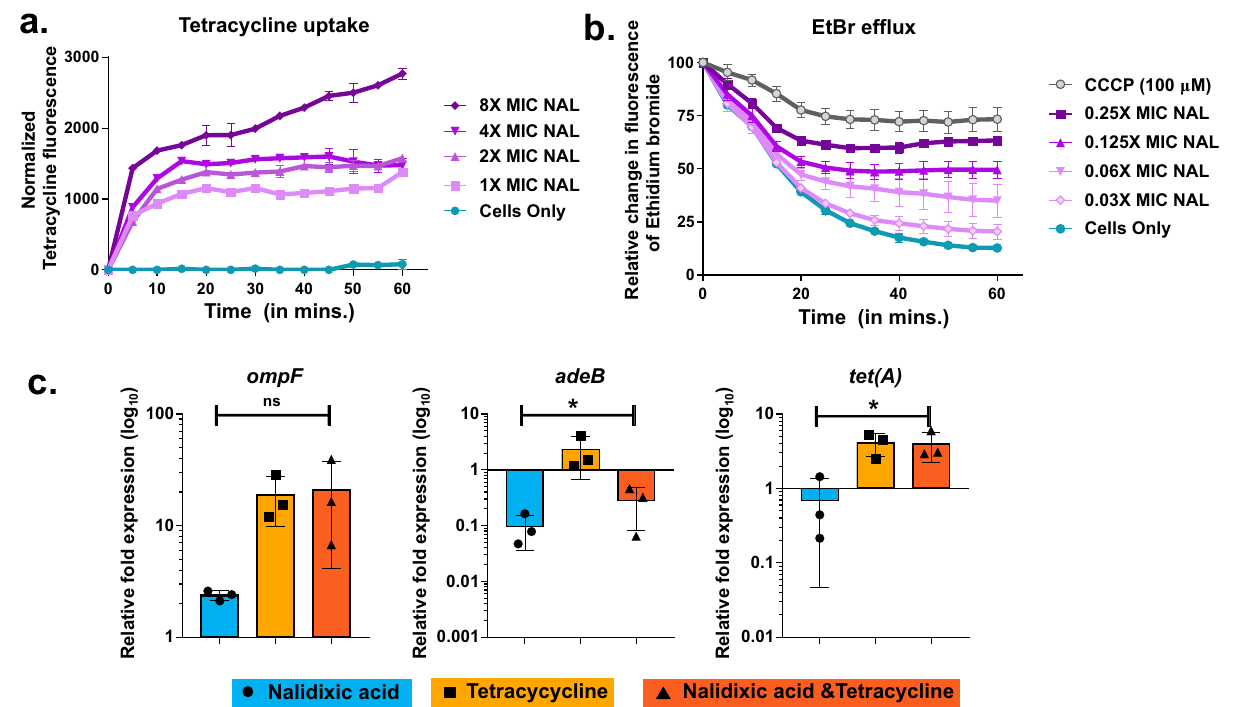
Fig. 2 Role of nalidixic acid in tetracycline entry into cell. a Tetracycline uptake assay. Nalidixic acid enhances the uptake of tetracycline in A. baumannii AYE. The concentration of tetracycline was kept constant at 128 mg/L, which is not inhibitory for OD 600nm ~ 0.5 cells. The increasing concentration of nalidixic acid was added (here, 1× MIC corresponds to 512 mg/L), as indicated in the subset above. Control cells represent bacterial cells without nalidixic acid treatment but with the same amount of tetracycline. Tetracycline does not show intrinsic fl uorescence as “ cells only, ” i.e., cells without nalidixic acid treatment do not show an increase in fl uorescence with time. Data are normalized with respect to tetracycline fl uorescence at time zero. Data are represented as mean with SD from two independent experiments. b Ethidium bromide (EtBr) ef fl ux inhibition assay. Increasing concentration of nalidixic acid caused a concentration-dependent decrease in ef fl ux of EtBr (a common substrate for many ef fl ux pumps). A. baumannii AYE cells without nalidixic acid “ Cells only ” caused maximum ef fl ux of EtBr. Proton uncoupler carbonyl cyanide m-chlorophenyl hydrazone (CCCP) acts as ef fl ux pump inhibitor (positive control) for this experiment. c Relative expression of tetracycline importer, i.e., outer membrane protein ( omp33 ) and tetracycline exporters (ef fl ux pump) adeB and tet(A) after nalidixic acid, tetracycline, or a combination of both (at 0.75× MIC). Expression was measured by quantitative RT-PCR and normalized to no-drug treatment in A. baumannii AYE. Data represent three independent biological